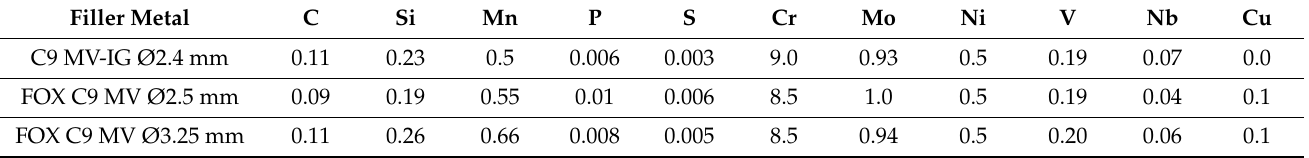
Table 2. Filler metal chemical composition (%).